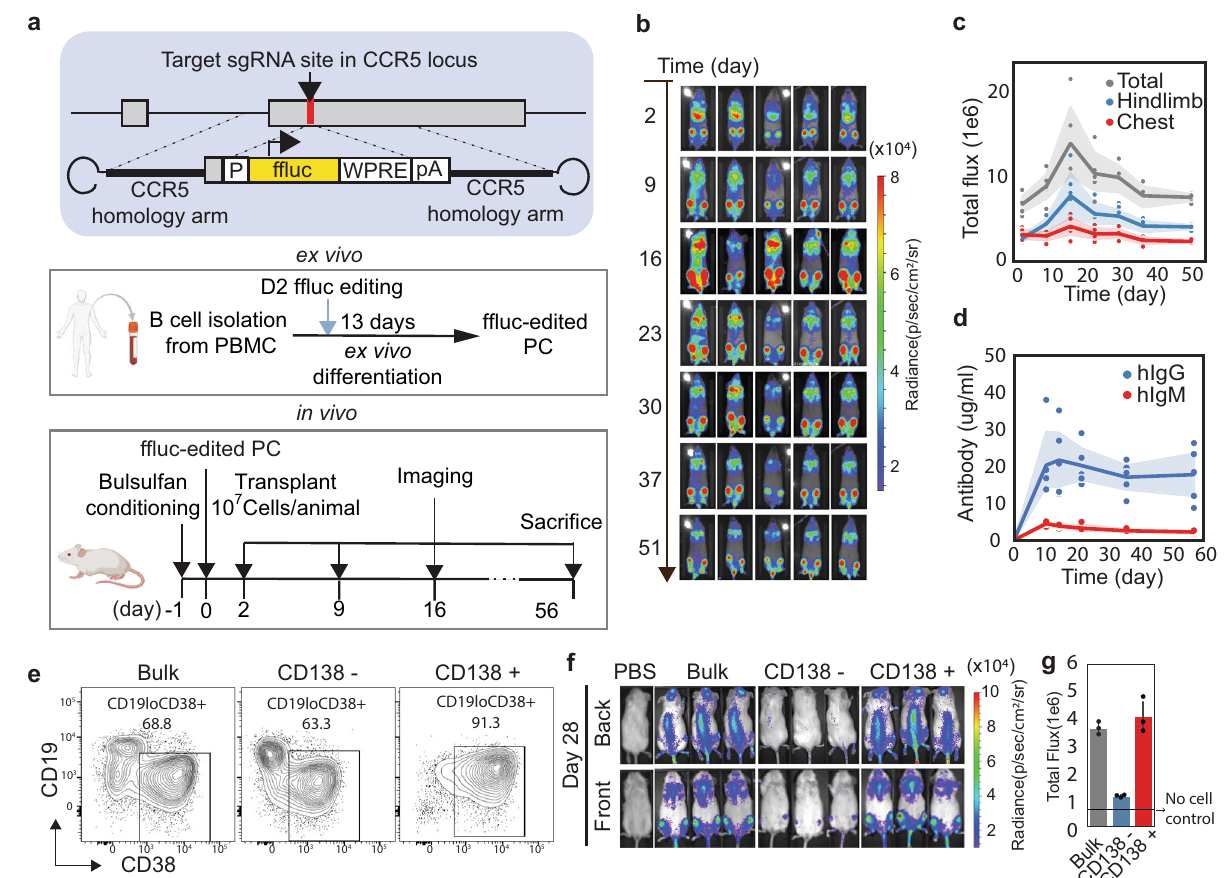
Fig. 3 | Ex vivo differentiated PCs home to BM and CD138+ PC is the main population engrafted. a Schematic of fi re fl y luciferase showing the homology- directedrepairstrategy,theBcellengineeringanddifferentiationstrategy,andthe in vivo engraftment and tracking strategy. It was partially created with BioR- ender.com. b Representative images from an in vivo engraftment experiment tracking engineered B cells from Day 0 to day 51 using fi re fl y luciferase imaging by IVIS ( n =10 animals, two independent donors. The imaging data is representative from a single donor; the data from donor two is in Supplementary Fig. 3a, b).